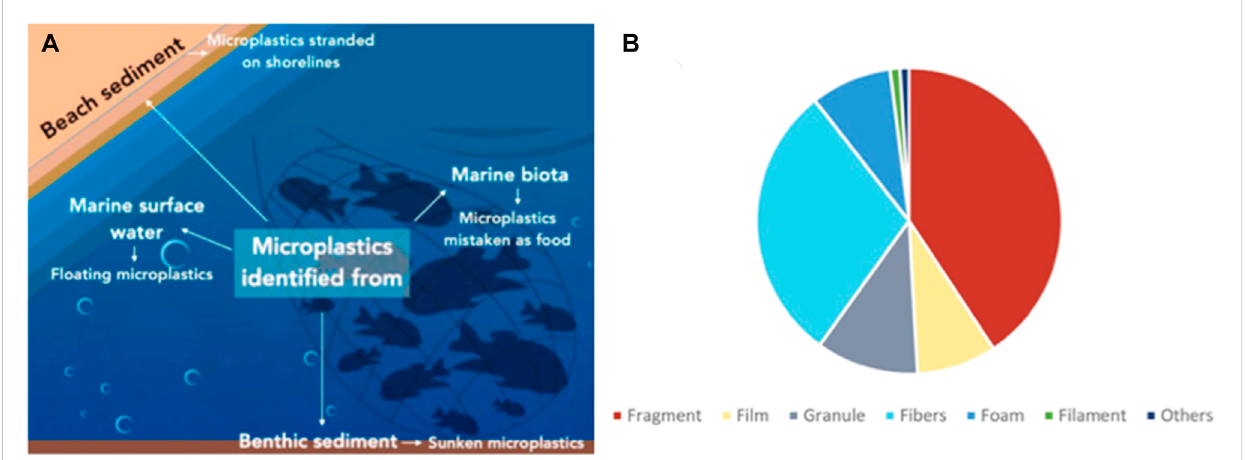
FIGURE 3 (A) Schematic diagram representing the presence of microplastics in the marine environment: in beach sediments, water column, benthic sediments, and marine biota. (B) Overall composition of microplastic types found across beach sediments, seawater, benthic sediments, and